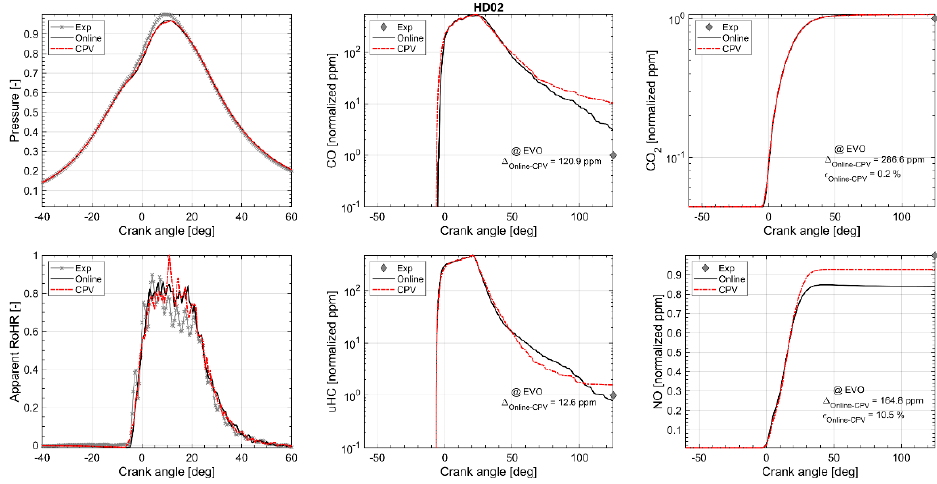
Figure A2. Engine performance and emissions for operating point HD02 (1300 rpm, 22.0 bar IMEP).